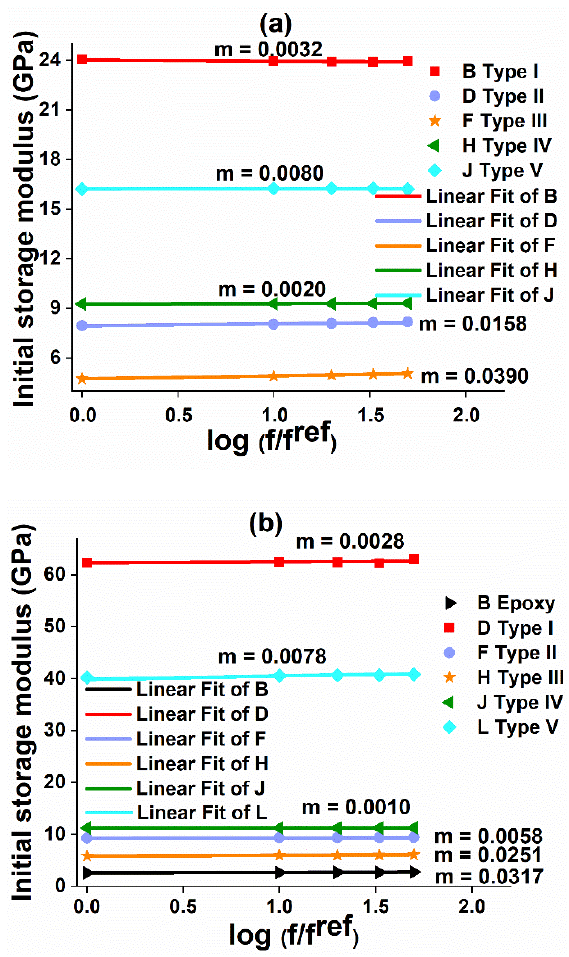
Figure 10. Frequency sensitivity coefficient: ( a ) GFRP and ( b ) epoxy and CFRP composite.